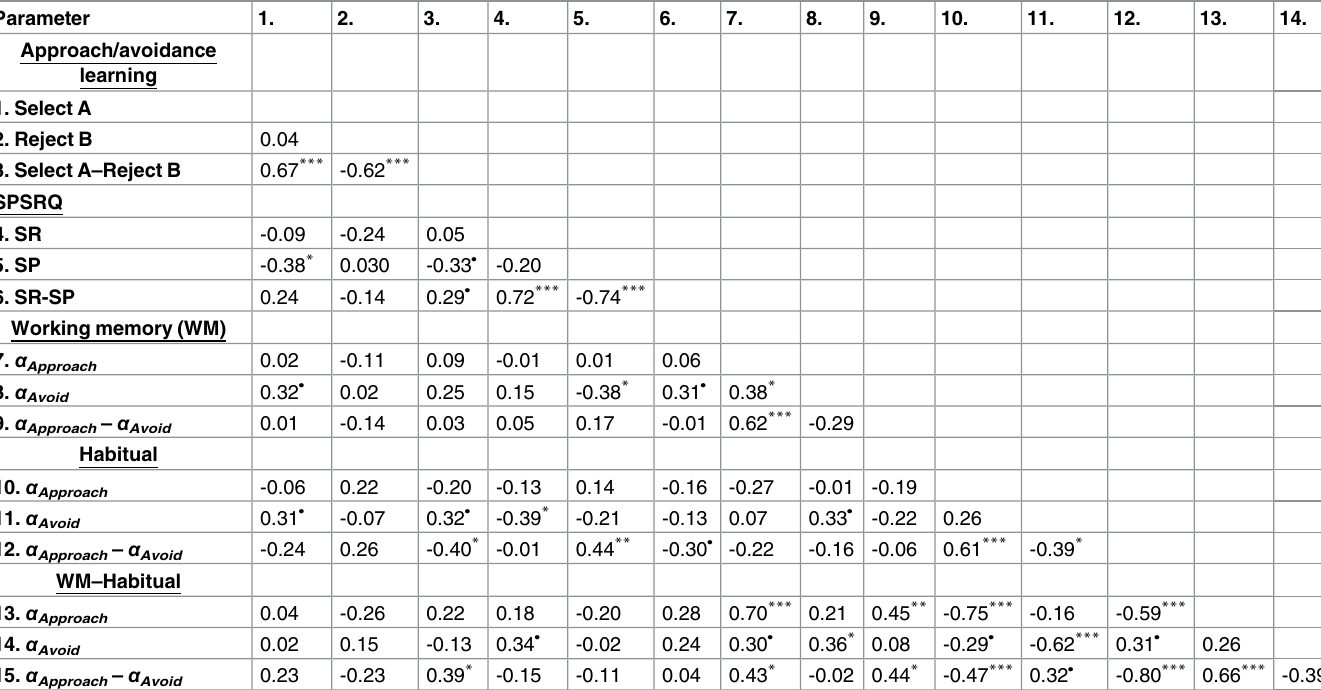
“Working memory” and “Habitual” refers to the two different learning systems which can be assessed by fitting model parameters to behaviouraldata during the training and testing phase, respectively